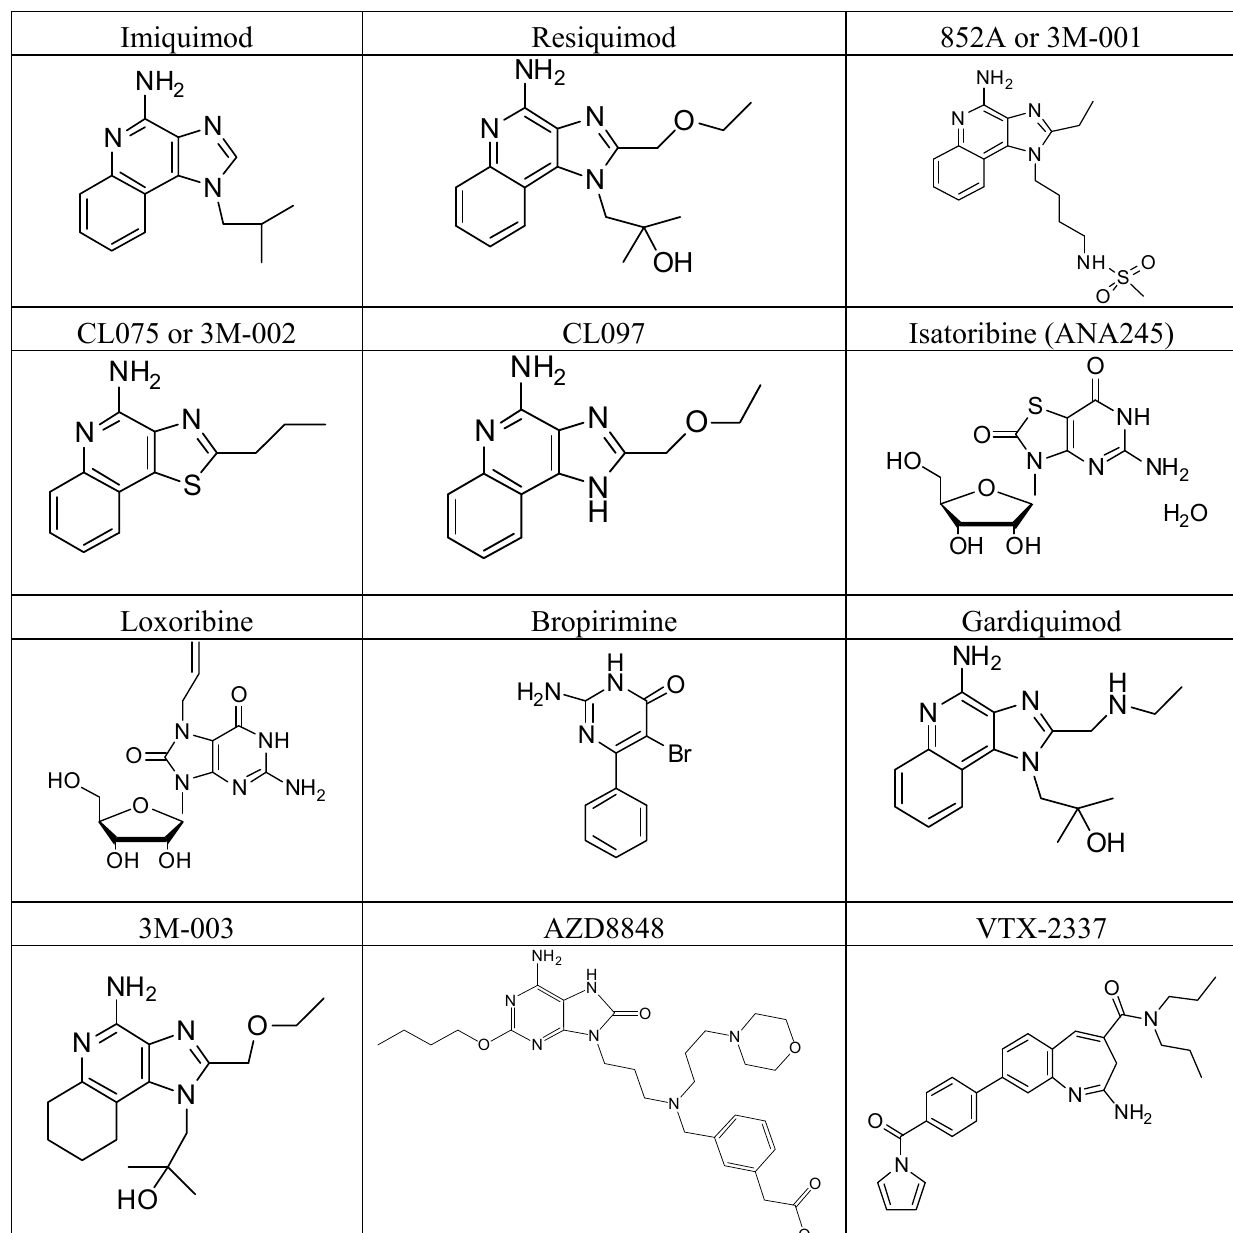
Figure 2. TLR7 and TLR8-recognizing synthetic nucleoside analogues.